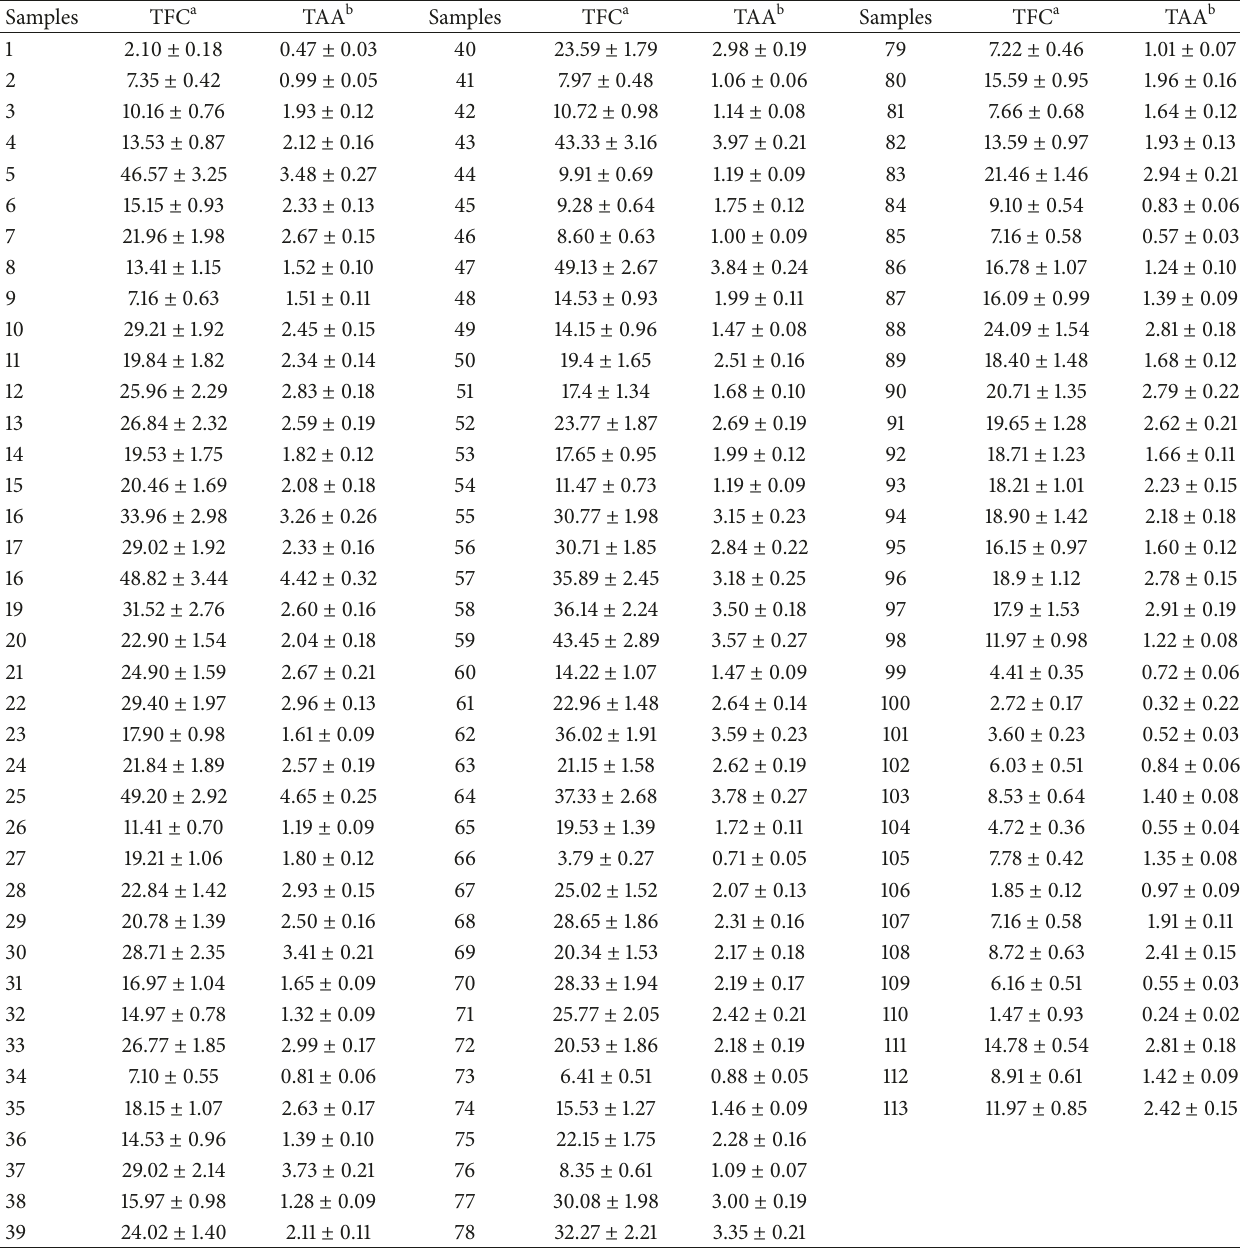
Table 1: The total flavonoids content (TFC) and total antioxidant activity (TAA) of Ginkgo biloba